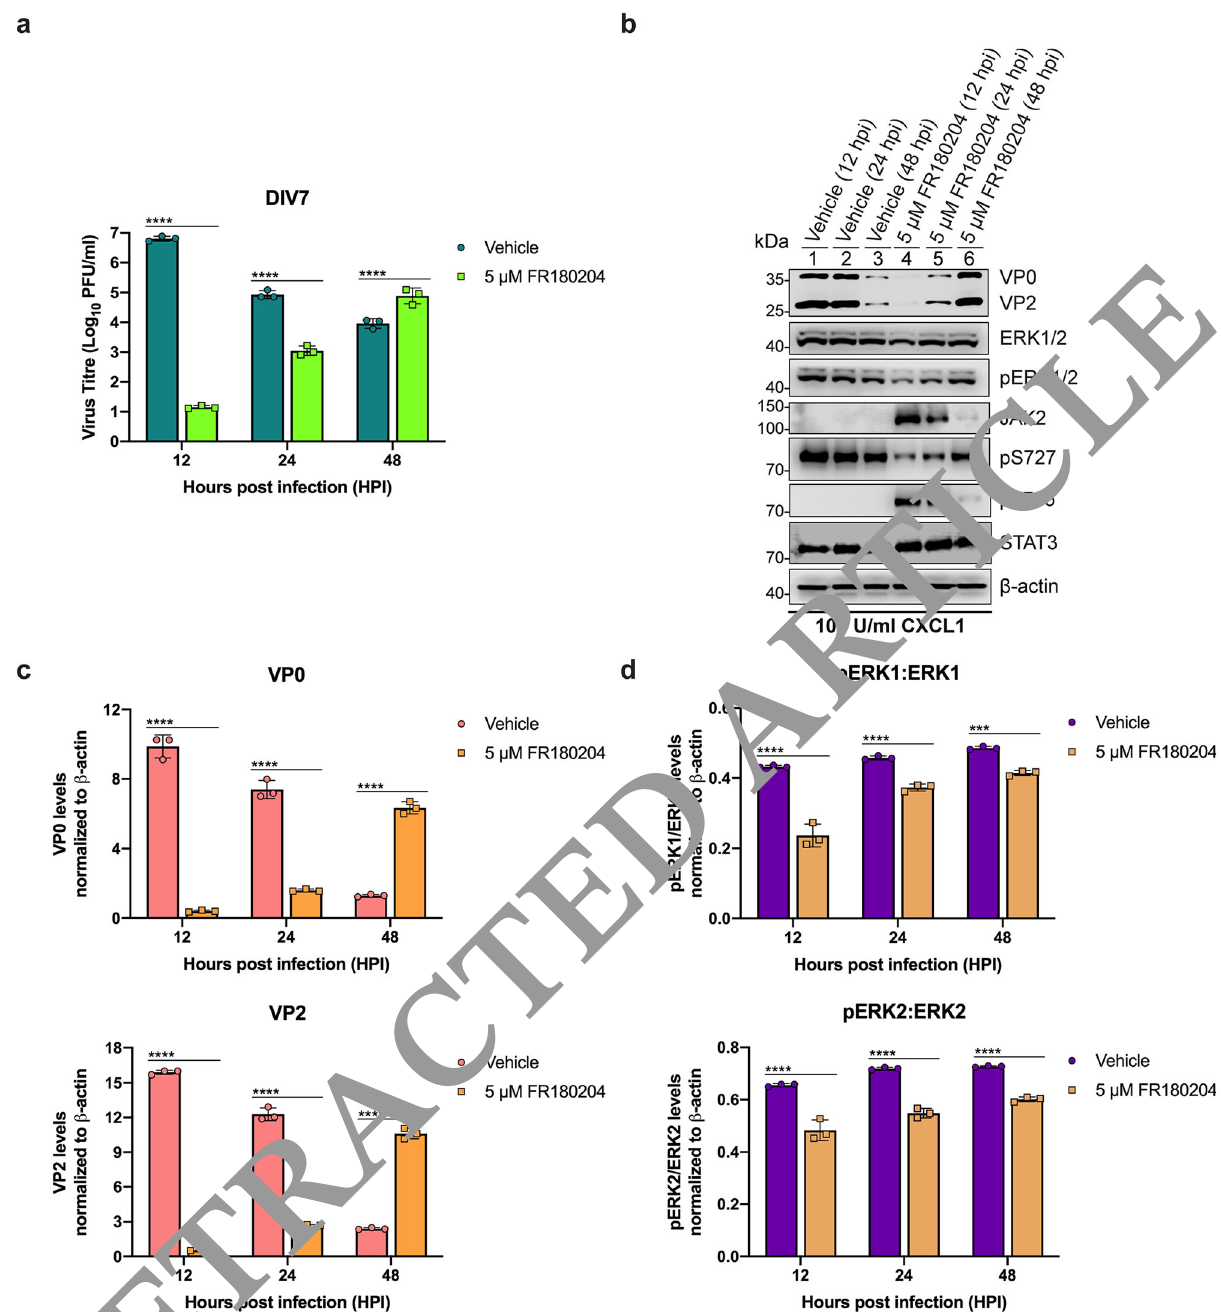
Fig. 5 Blocking CXCL1 signaling by pERK1/2 inhibition reduces viral replication in neuronal cultures. a Inhibiting ERK1/2 decreased viral titers at 12 and 24 hpi in DIV7 neuronal cultures. b Immunoblotting of S41-infected DIV7 neuronal cultures treated simultaneously with FR180204 (5 µ M) and CXCL1 (100 U/ml) at 12, 24 and 48 hpi. ERK1/2 inhibition delays the expression of HEVA71 viral proteins. Immunoblot representative of 3 biological repeats is shown. Bar charts below show the quanti fi cations for each protein. c VP0 and VP2 levels decreased at 12 and 24 hpi with ERK1/2 inhibition. d pERK1/2 to ERK1/2 ratios were reduced at all timepoints in FR180204-treated cultures. Exact P value for pERK1 to ERK1 ratio with FR180204 at 48 hpi = 0.0001. β -actin was used as a loading control for immunoblotting experiments. MOI of 1 was used for all experiments. Data are expressed as the average with error bars representing ±SD from 3 independent experiments (n = 3). Statistical analyses were performed with two-way ANOVA corrected using Bonferroni post- test. (*** P < 0.001 and **** P < 0.0001). Source data are provided as a Source Data fi a subset of cytokine and chemokines. Of these, elevated levels of CXCL1 are detected only in patients suffering from severe HFMD involving neurological complications. CXCL1, released from infected astrocytes by VP4, activates its neuronal receptor CXCR2 to phosphorylate downstream ERK1/2 that, in turn, promotes HEVA71 replication in neurons (Supplementary Fig. 25).